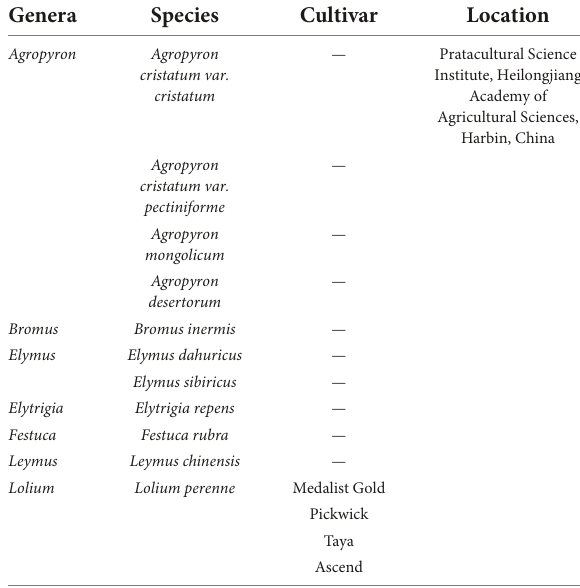
TABLE 1 Details of the 14 grass accessions used in this